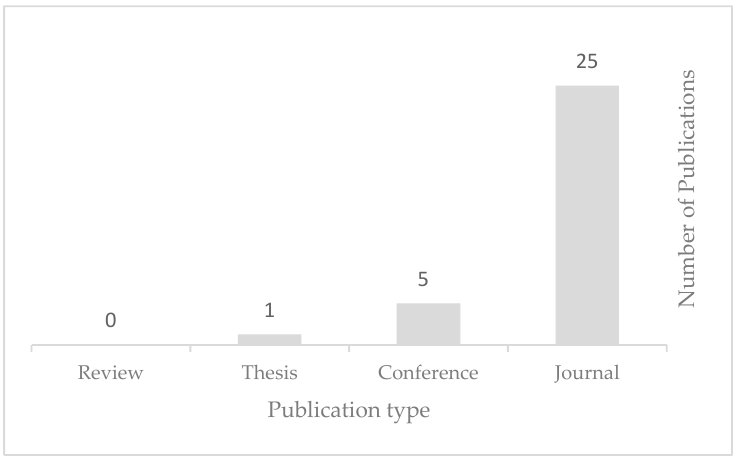
Figure 6. Categorization based on document type.